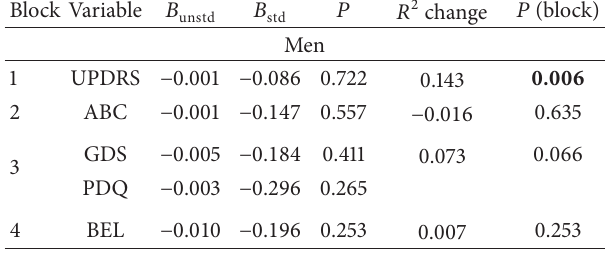
Table3:RegressionmodelresultsforSELF,FAST,andDIFFwalking speeds.